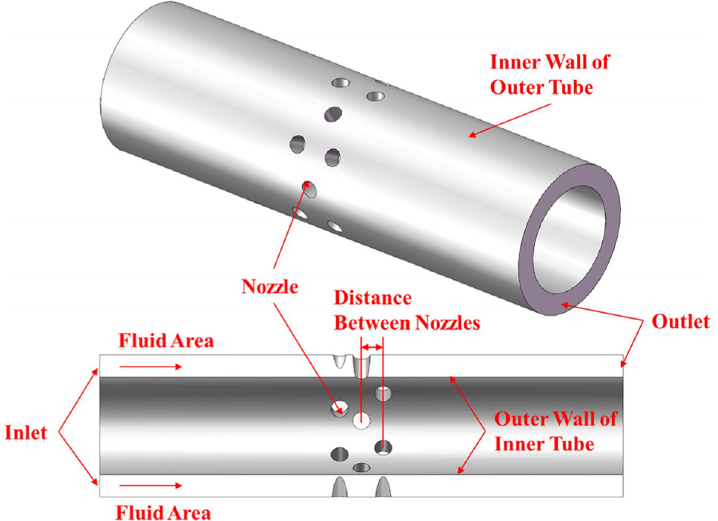
Fig. 14 Simulation model for the analysis of the jet device outer annulus over-flow